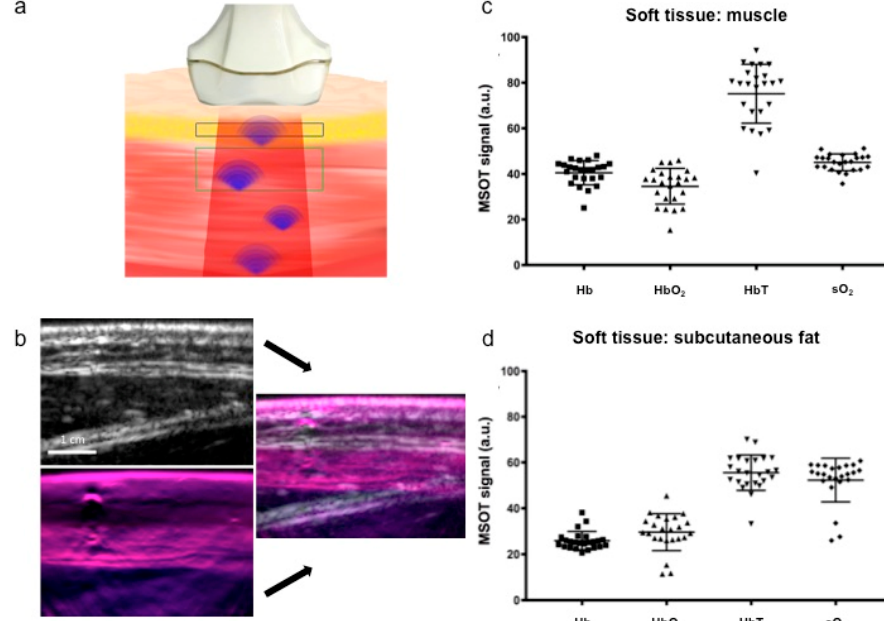
Figure 1. ( a ) MSOT principle: Based on the photoacoustic effect, laser pulses cause thermoelastic expansion within the tissue of interest followed by emission of detectable ultrasound waves. Light source and detector are combined in one probe. Due to different absorber properties, spectral unmixing enables quantitative analysis of the intrinsic biomarkers hemoglobin and oxygen saturation non-invasively. Regions of interest were placed within the muscular (green rectangle) and the subcutaneous fat tissue (blue rectangle). ( b ) Exemplary ultrasound (top left, scale: 1 cm) and pseudocolor-coded MSOT signals (bottom left) are merged into an overlay image (right). Acquired MSOT values of deoxygenated (Hb), oxygenated (HbO 2 ) and total hemoglobin (HbT) as well as oxygen saturation ( n = 24 each) reveal small to moderate deviation in muscular ( c ) and subcutaneous fat tissue ( d ).